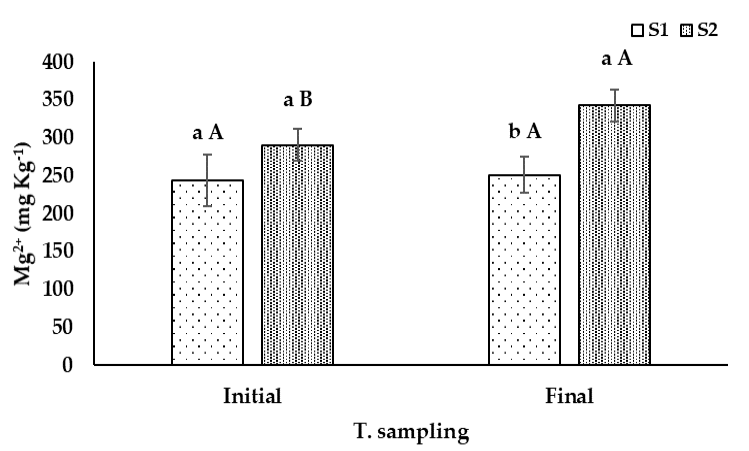
Figure 6. Interaction between time of sampling (T. sampling) (initial and final) and soil type (soils S 1 and S 2 ) for soil Mg concentration (mg kg −1 ). Lowercase letters are used for the comparison between soil type in each time of sampling and uppercase letters are used for the comparison between time of sampling for each soil type.